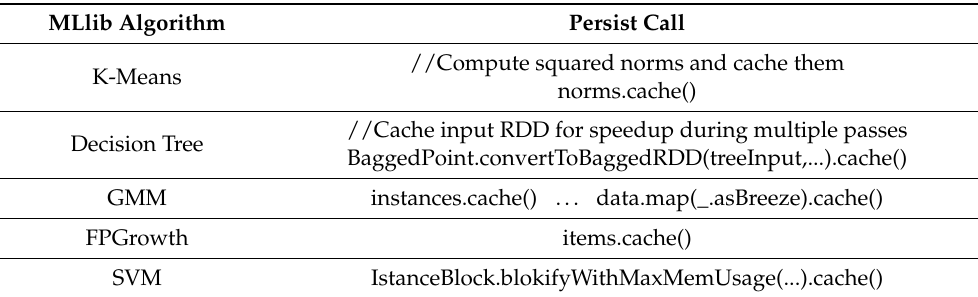
Table 2. Examples of persist calls in MLlib